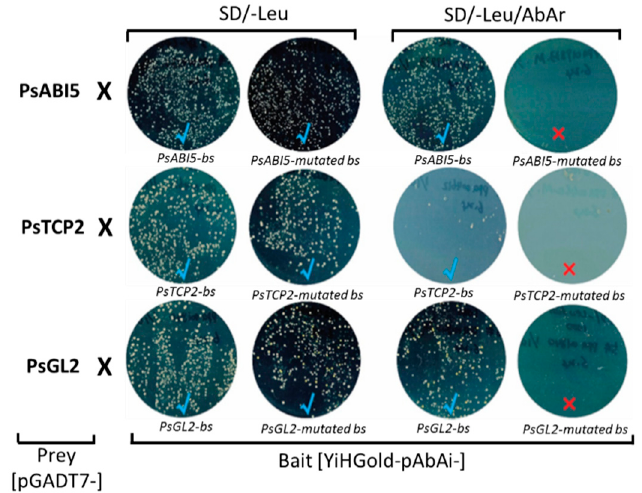
Figure 3. Confirmation of positive interactions by Yeast one-hybrid assay. Tandem repeats of cis-elements core sequences and their corresponding mutated sequences (Table S1), defined by the TFs bound to them, PsABI5, PsTCP2, and PsGL2, were synthesized and sub-cloned into reporter pAbAi vector (bait construct). The preys were prepared by extracting yeast plasmid from colonies showing positive interaction in the Yeast one-hybrid screen. A selective agar plate, SD / -Leu / AbAr (with AbAr above the minimal inhibitory concentration), was used to identify genuine positive interactions. The plates with distinct colonies are marked by “ √ ” (blue), while the plates without distinct colonies are marked by “ × ” (red).